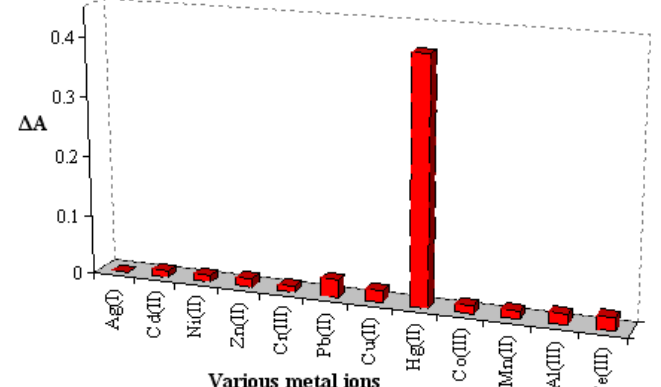
Fig. 2. The absorbance variations of the methanolic solutoion of 3-((3-mercaptophenyl) aminomethyl)benzene-1,2-diol at maximum wavelength for all the ions studies.